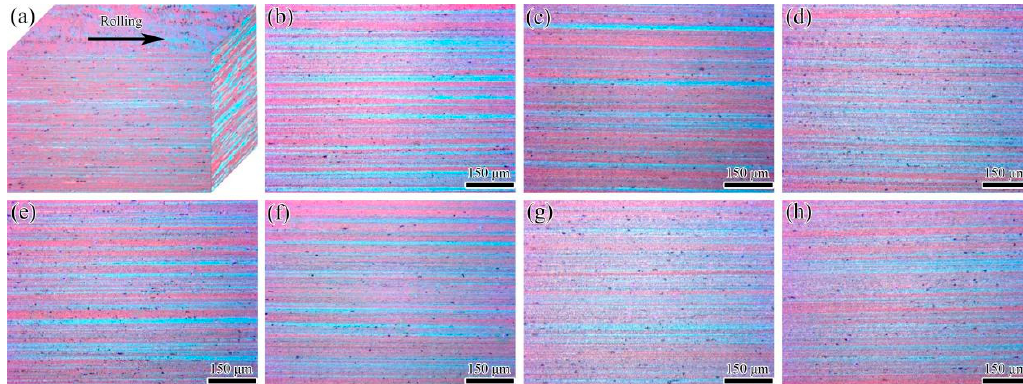
Figure 3. Optical microscopy (OM) images of the annealed 7005 aluminum alloy plate ( b ) before and ( c – h ) after different pre-tensile deformations (3%, 5%, 8%, 12%, 16%, and 20%, respectively, along the longitudinal section; non-etched), ( a ) shows a 3D diagram of the undeformed sample.